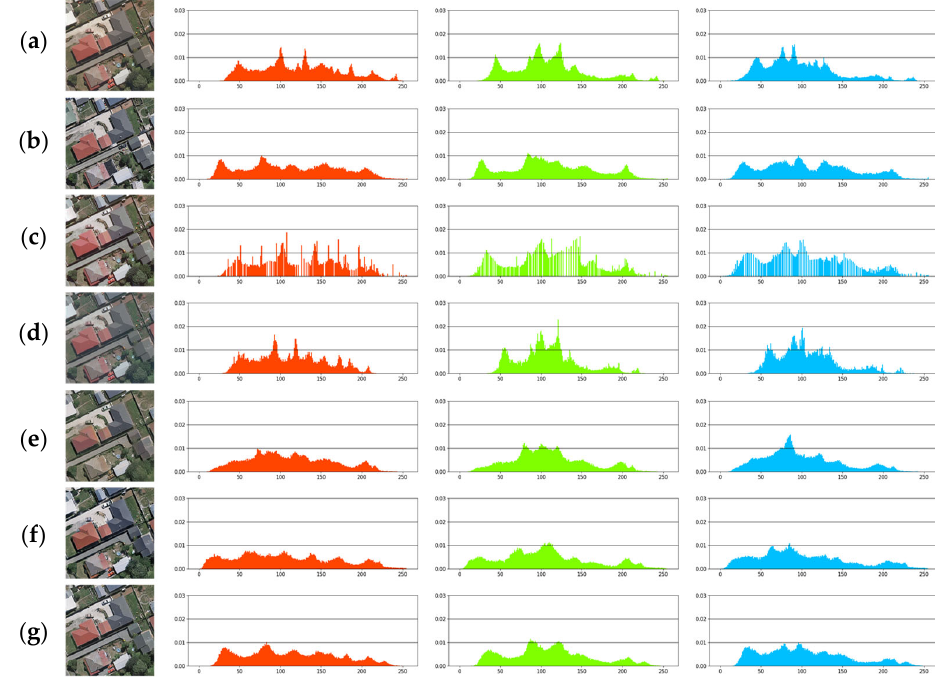
Figure 8. RGB histograms of the image color translation results obtained on the Wuhan University building change detection dataset, ( a ) 2012 image, ( b ) 2016 image, ( c ) HM, ( d ) Reinhard method, ( e ) DRIT, ( f ) UNIT, and ( g ) CycleGAN.